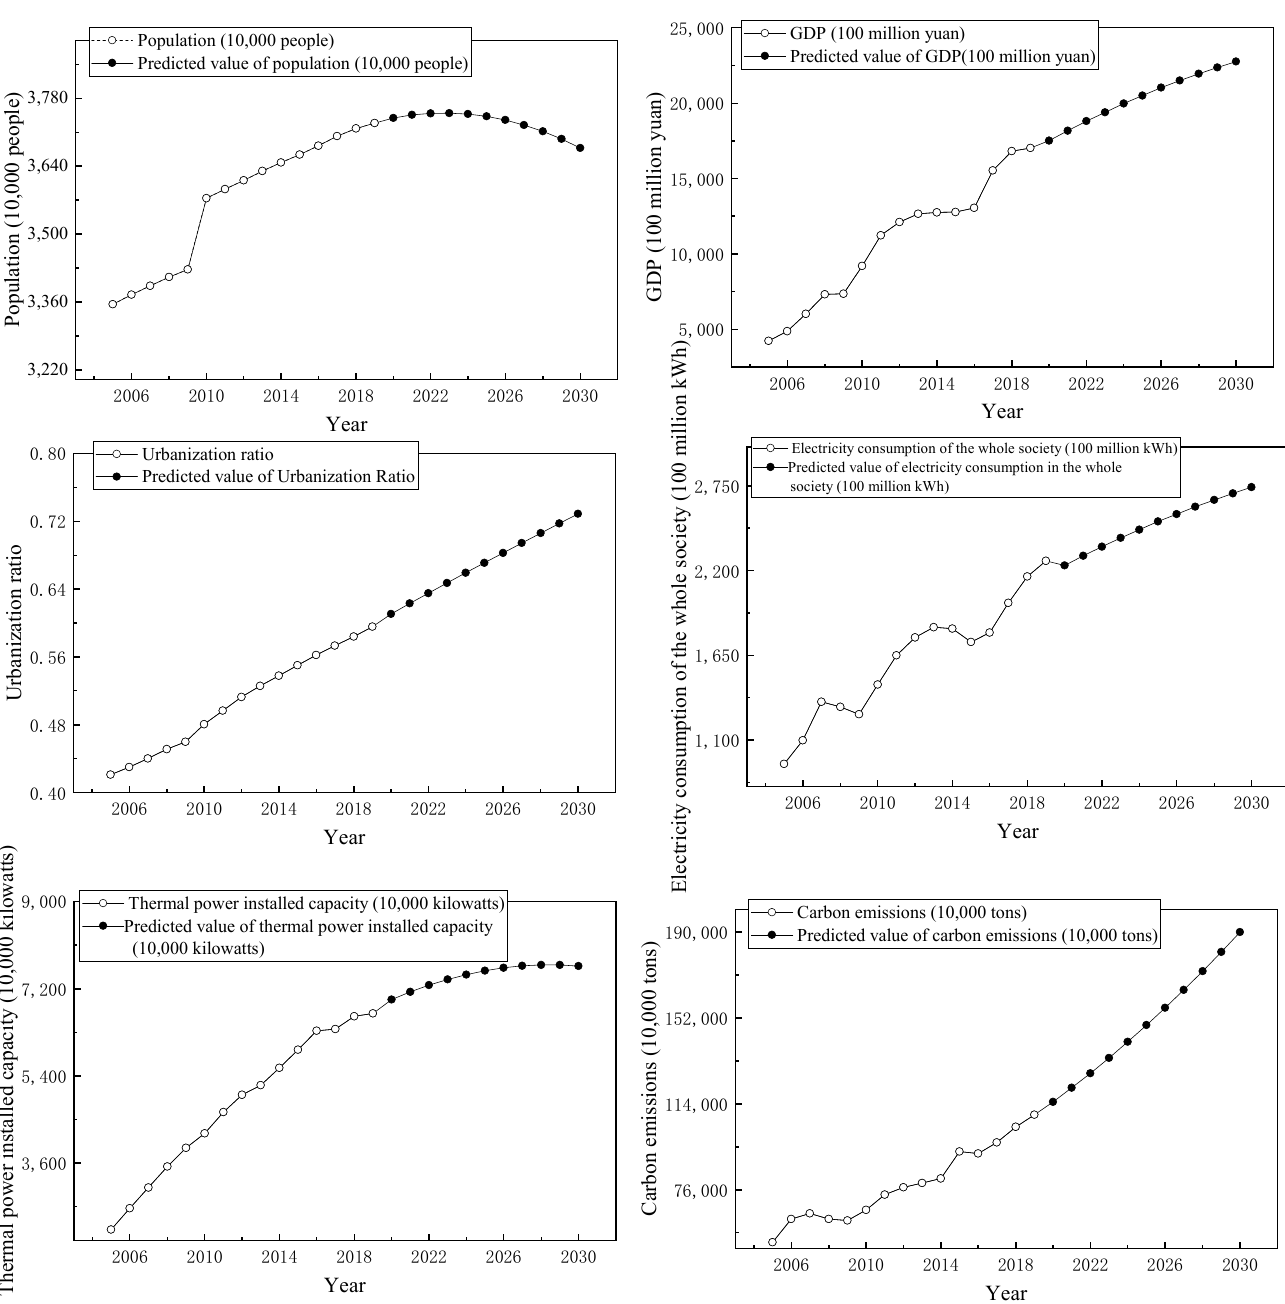
Figure 5. Trend forecast of influencing factors of coal demand in Shanxi Province.